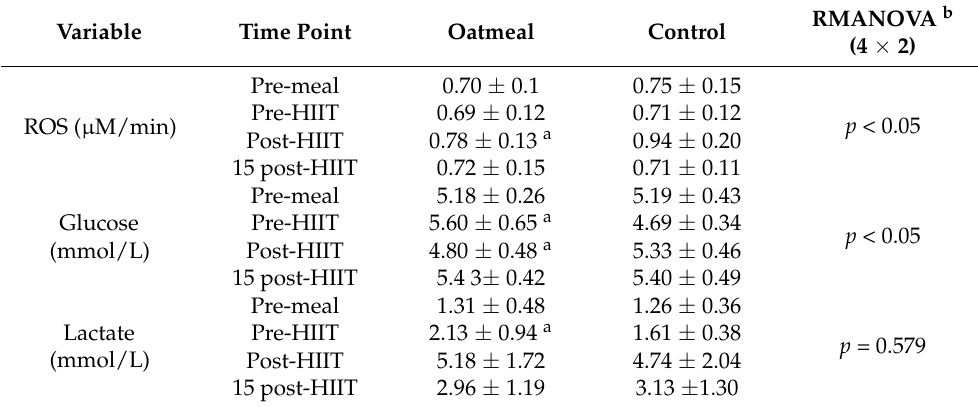
Table 3. Changes in the metabolic parameters in the oatmeal group and control group from pre-meal to 15 post-HIIT. Statistical differences were measured using